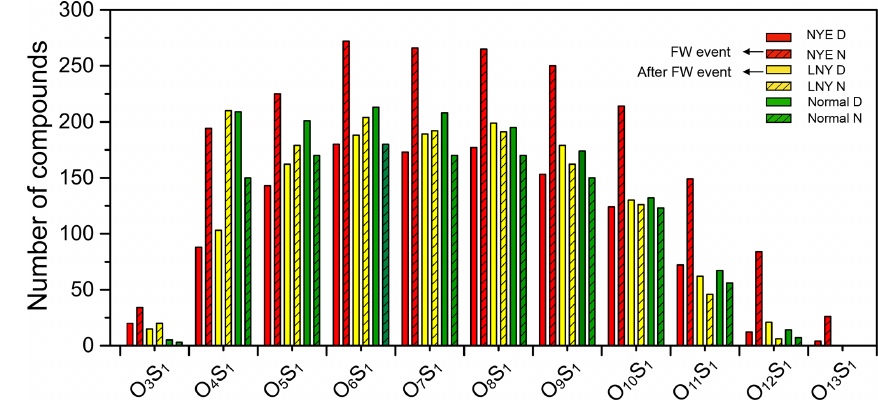
Figure 10. Classification of CHOS species into subgroups according to the number of O and S atoms in their molecules.